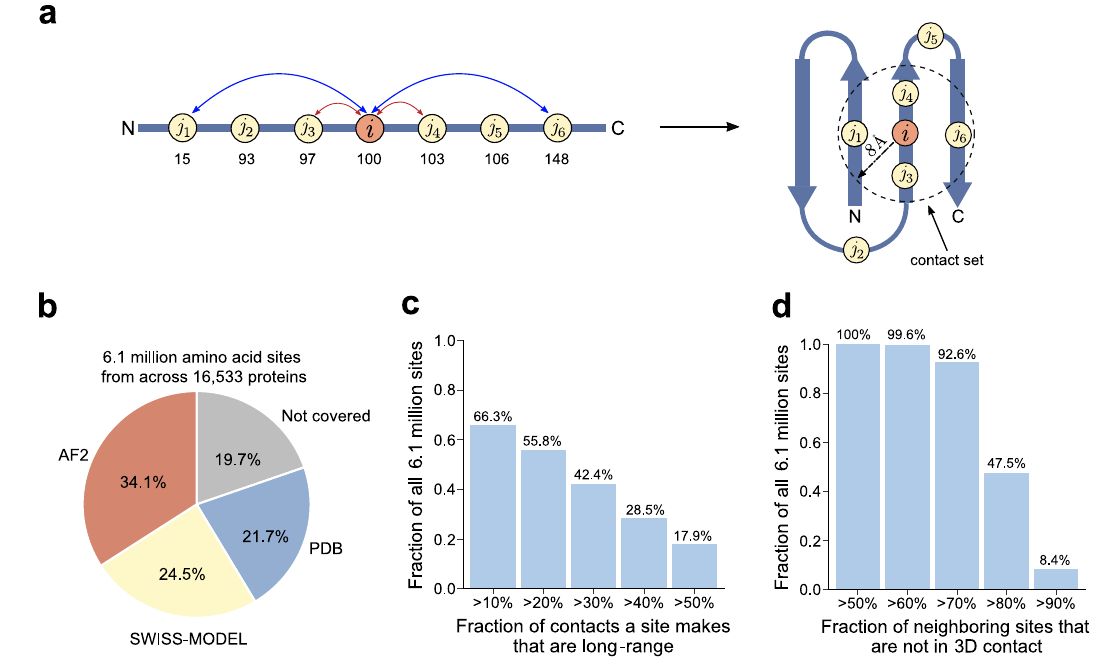
Fig. 2 Protein 3D context differs from 1D sequence context. a To quantify the 3D spatial context of each amino acid site ( i ), our framework de fi nes its contact set as the amino acid residues that are in contact (C β < 8 Å) with the residue. For the example index site ( i ), the contact set is ( i , j 1 , j 3 , j 4 , j 6 ). Numbers below the 1D sequence schematic represent residue sequence positions and illustrate that contact set residues may be distant in sequence from the index site. b The COSMIS framework covers 80.3% of the reference human proteome. De fi ning the contact set of an amino acid site requires protein 3D structures. We used PDB and SWISS-MODEL as our primary sources of protein 3D structures. For proteins with no structure in the PDB or SWISS- MODEL that meet our criteria (Methods), we analyze models from the AlphaFold2 structure database. Numbers inside the pie chart represent fractions of the human reference proteome (20,600 proteins) for which we used the corresponding protein structure resource to compute COSMIS scores (Supplementary Data 1). c Contact sets capture long-range sites (separated by more than 15 residues along the 1D sequence) that interact in 3D. For example, residues j 1 and j 6 in panel a are not neighbors in 1D sequence, but nevertheless form long-range contacts with the index site i . The bar plot shows the fraction of all 6.1 million sites with at least a certain fraction of long-range 3D contacts in their contact sets. d Many neighboring sites in 1D sequence do not form 3D contacts with an index site. De fi ning the contact set eliminates these sites from consideration. For example, residues j 2 and j 4 in panel a are 1D sequence neighbors (within 15 residues) of the index site i but do not form 3D contacts with it. The bar plot shows the fraction of all 6.1 million sites that have at least a certain fraction of 1D sequence neighbors that do not form 3D contacts. PDB Protein Data Bank, AF2 AlphaFold2. Source data are provided as a Source Data fi le.